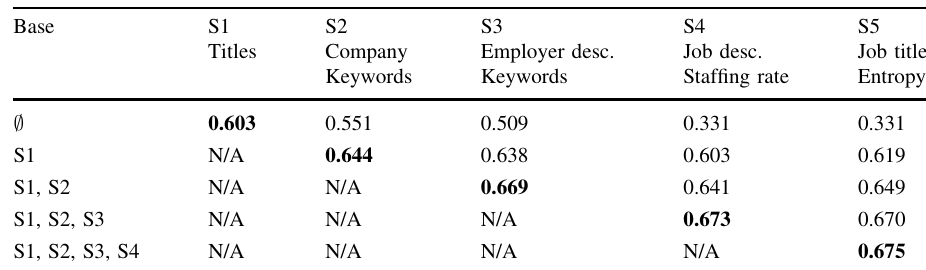
Table 8 Results for different combinations of feature sets